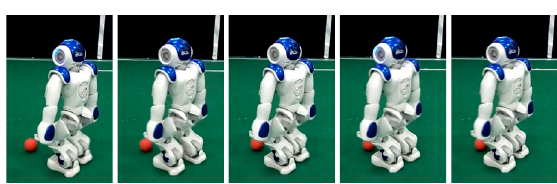
Fig. 15. Ball tracking photo sequence in real